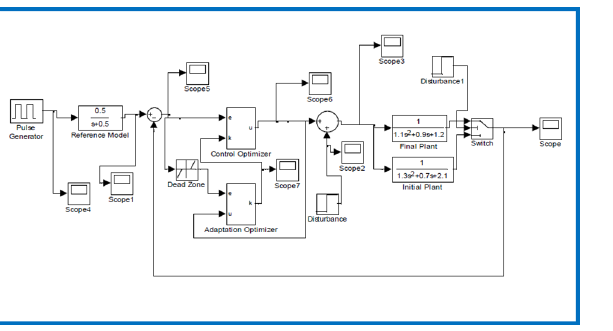
Fig 6. Simulink simulation model for the second scenario.